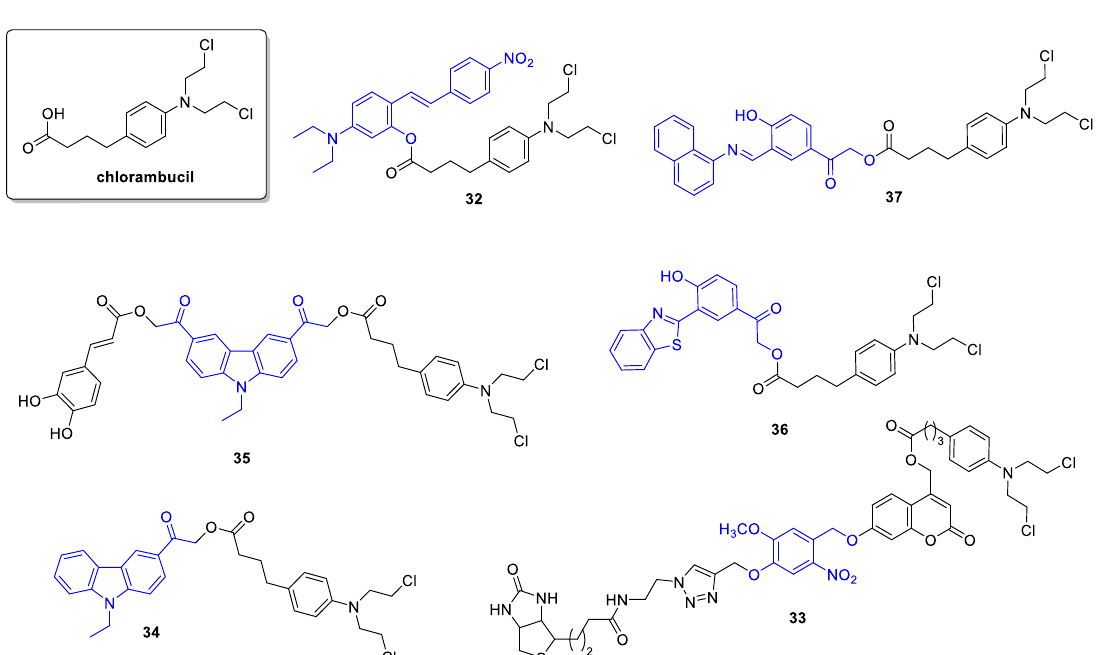
Figure 7. Photoactivatable chlorambucil derivatives, the PPG indicated in